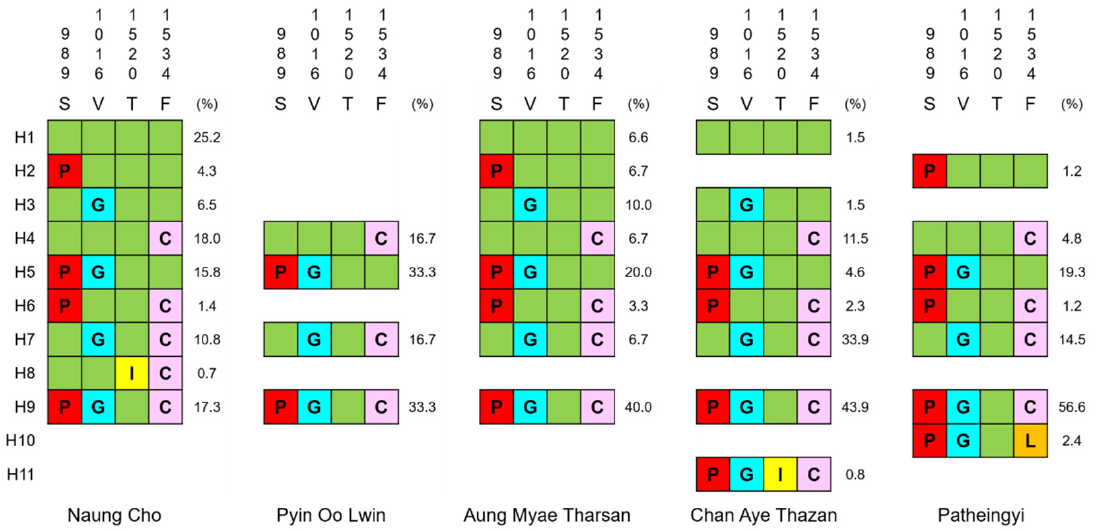
Figure 3. Patterns and frequencies of vgsc haplotypes based on major kdr mutations in Ae. aegypti vgsc from 5 study sites. The wild type amino acids are the column rows and colored boxes indicate mutations. Single or concurrent kdr mutations in the vgsc DII-S6 and DIII-S6 generated 11 distinct haplotypes of the gene. Patterns and frequencies of each haplotype differed by study site.